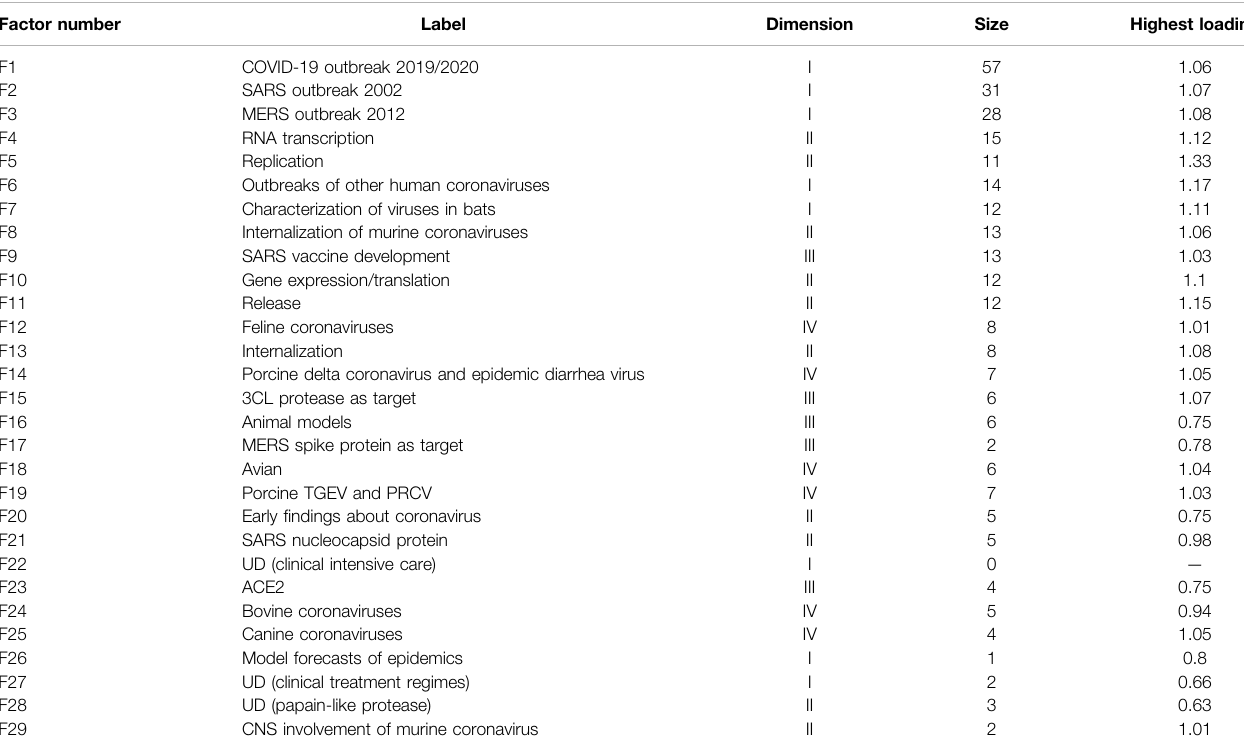
TABLE 1 | Overview of a 29-factor model. Factor